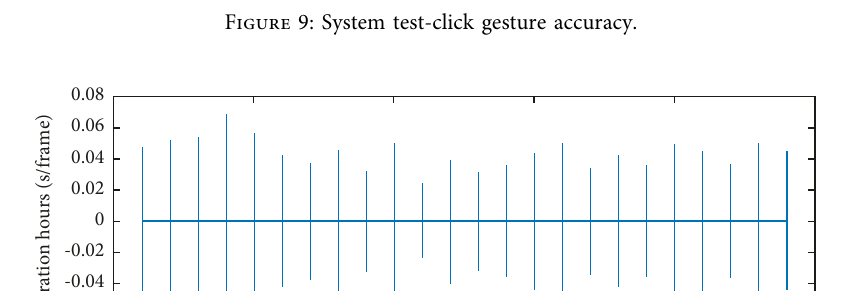
Figure 9: System test-click gesture accuracy.